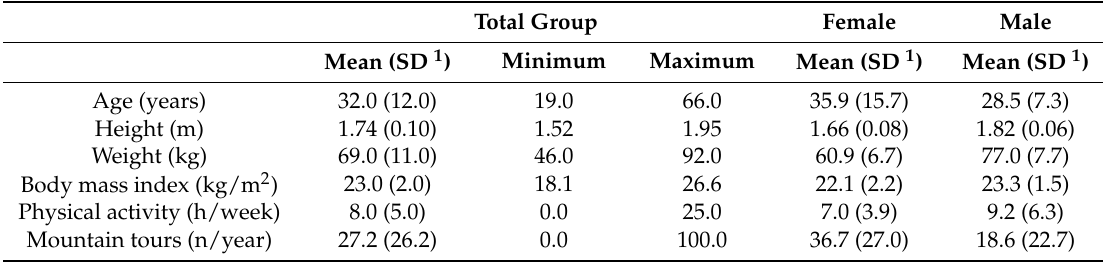
Table 1. Demographic data of the study participants for the total group and by